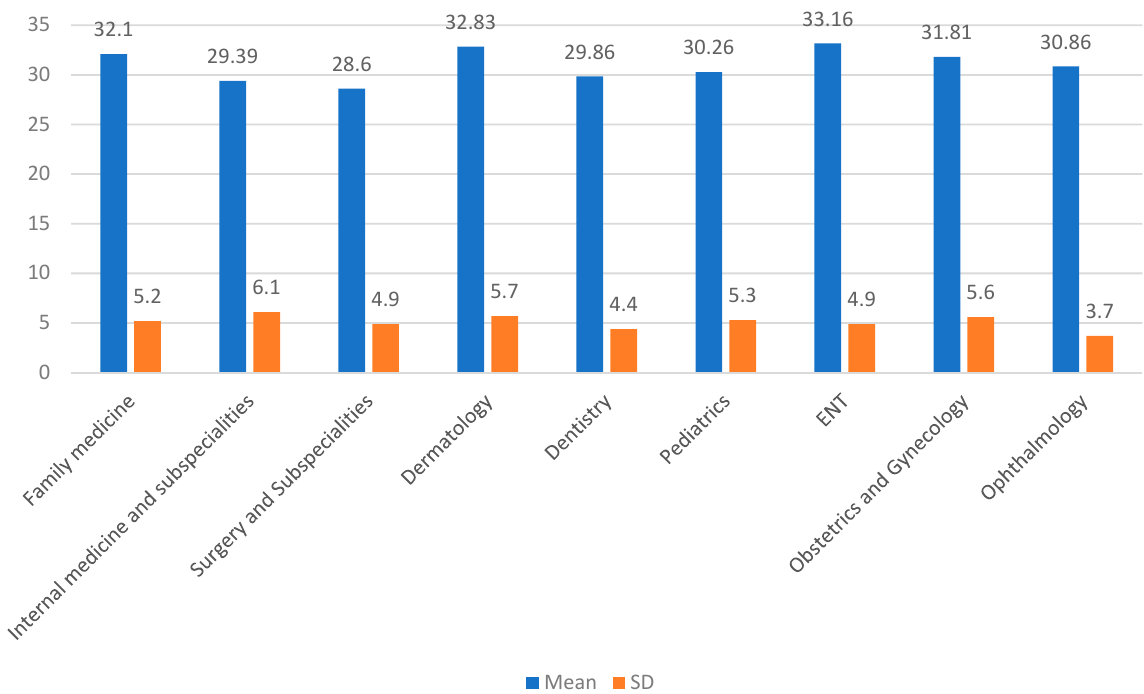
Figure 2. Distribution of patients’ satisfaction scores as per the specialties (mean and SD). Of the 720 participants, 394 (54.7%) had high satisfaction, 266 (36.9%) had average satisfaction, and 60 (8.3%) had poor satisfaction with the virtual outpatient telemedicine clinics (Figure 3).